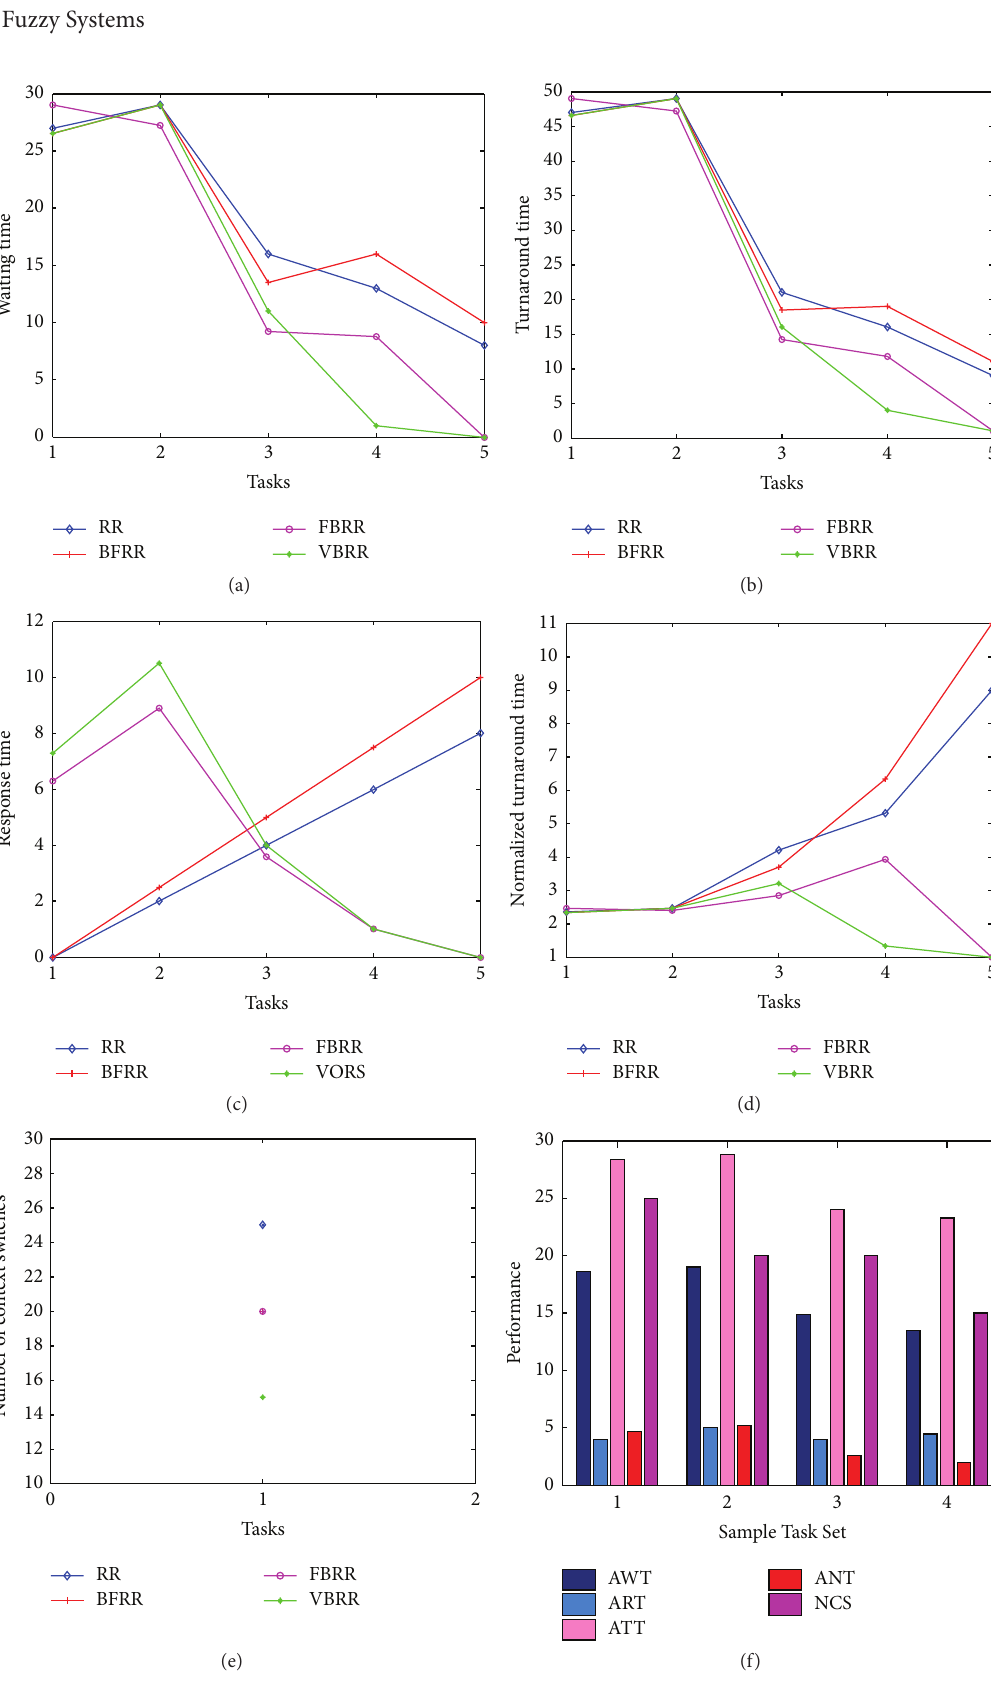
Figure 10: (a) Waiting time (Sample Task Set). (b) Turnaround time (Sample Task Set). (c) Response time (Sample Task Set). (d) Normalized turnaround time (Sample Task Set). (e) Context switches (Sample Task Set). (f) Overall performance (Sample Task